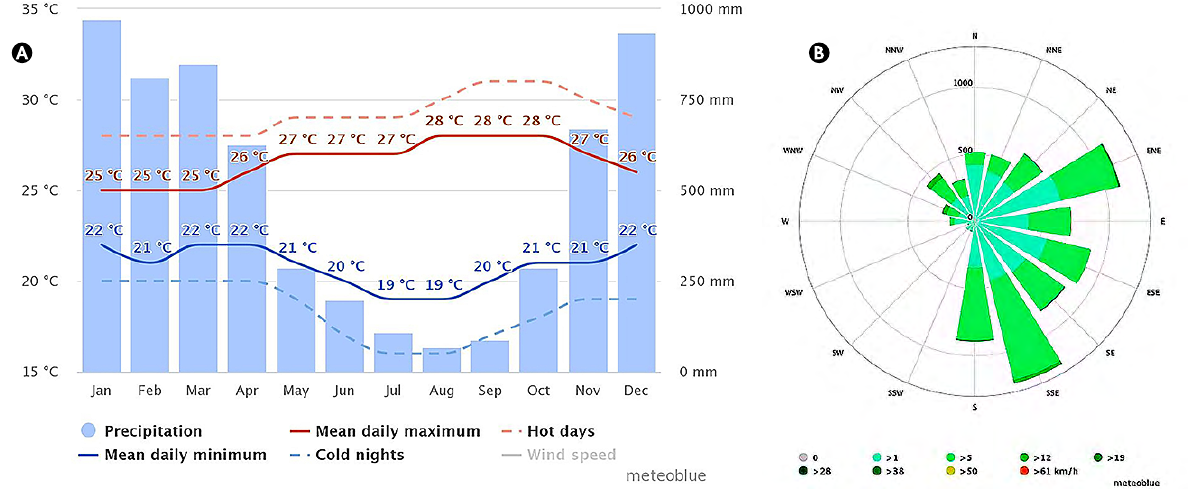
Figure 1. (A) Temperature and precipitation; (B) Wind